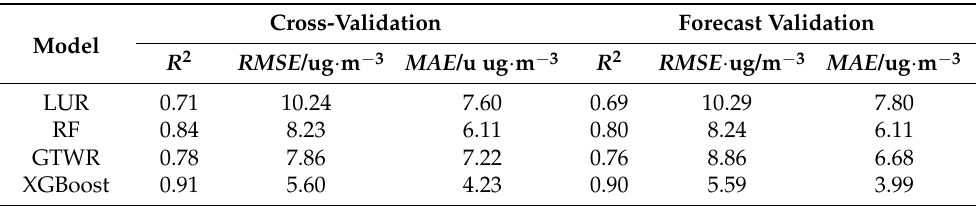
Table 4. activity intensity.